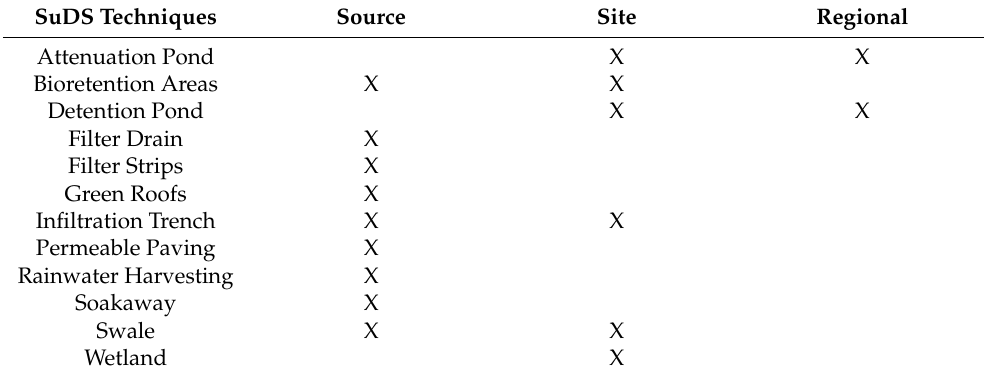
Table 3. SuDS techniques and